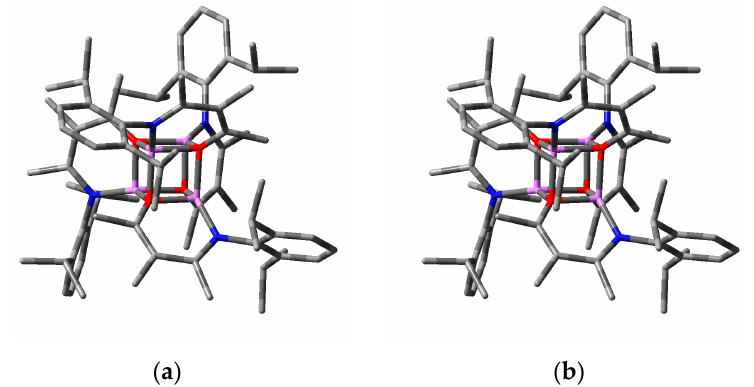
Figure 4. DFT calculated structures of 3c : ( a ) in the crystallographically determined D 2 geometry; and ( b ) in the alternate S 4 geometry ( 3c ′ ). Hydrogen atoms are omitted.